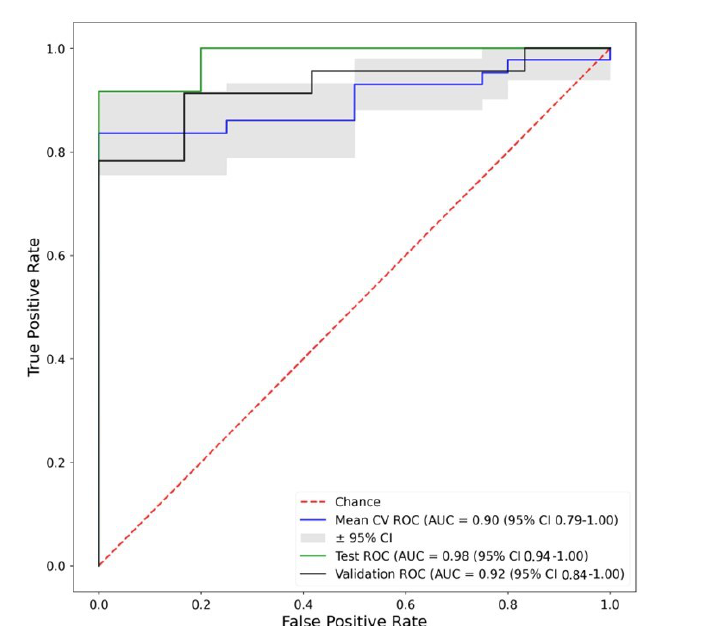
Figure 7. ROC curves of the best performing (by validation AUC and minimum accuracies) machine learning classifier trained on Fingerprint A—Random Forest. Corresponding Accuracies—Training: 0.74 , Test: 0.8, Validation: 0.75. Key: Mean CV ROC—Mean cross validation ROC from training dataset, Test ROC—ROC from test dataset, Validation ROC—OC from validation